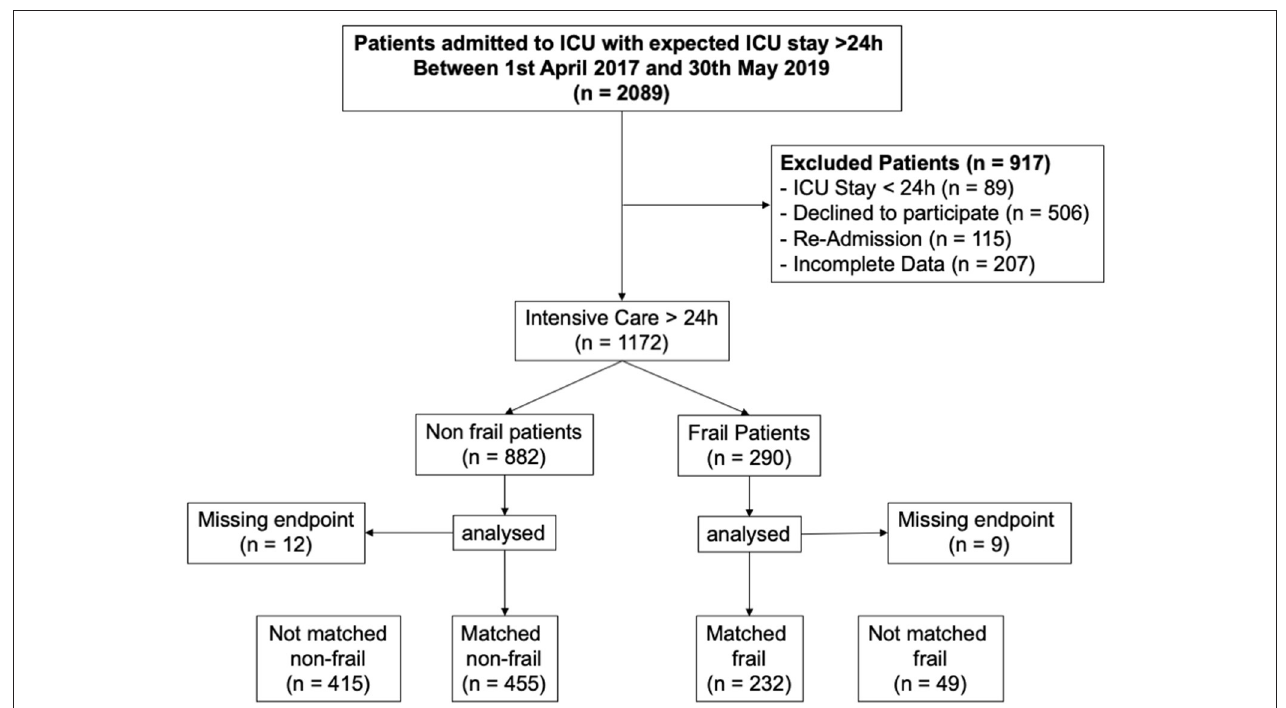
FIGURE 1 | STROBE